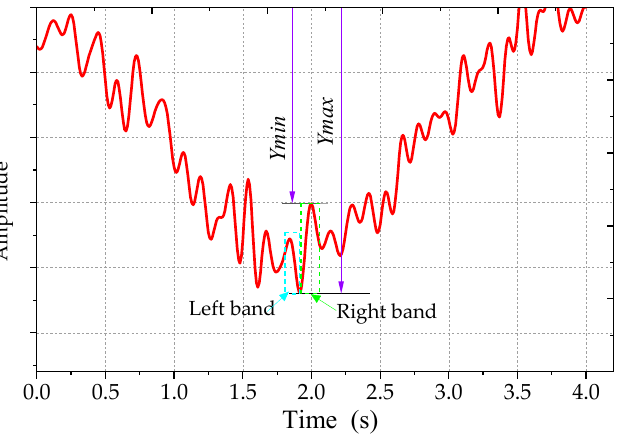
Figure 3. Principle of the DLA by experimental method.